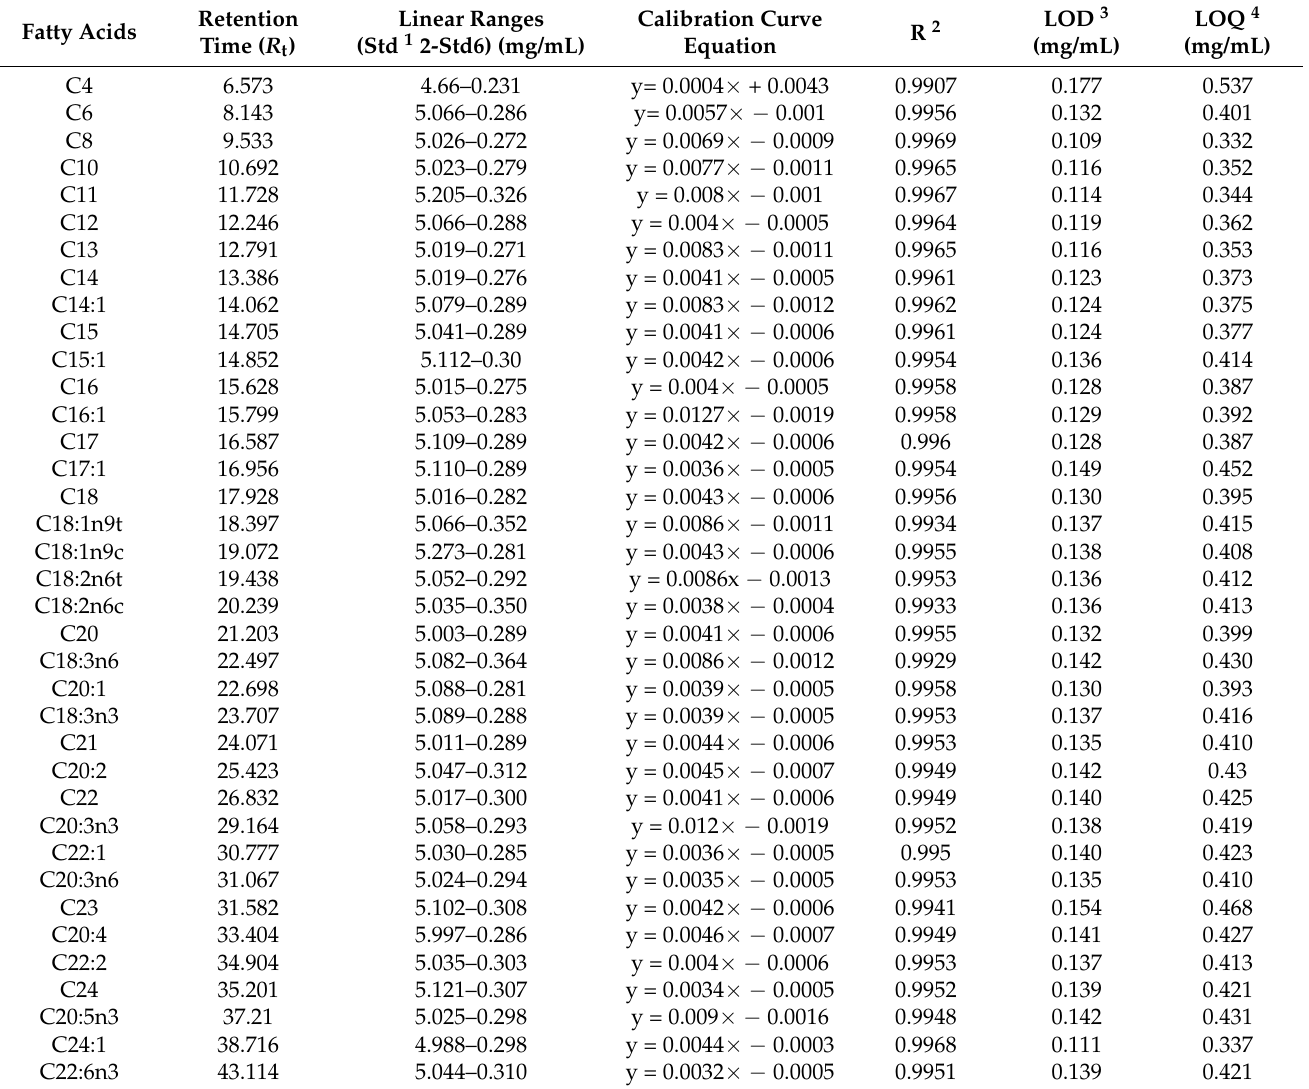
Table 1. Linearity and estimated regression parameters for FA standard obtained from calibration